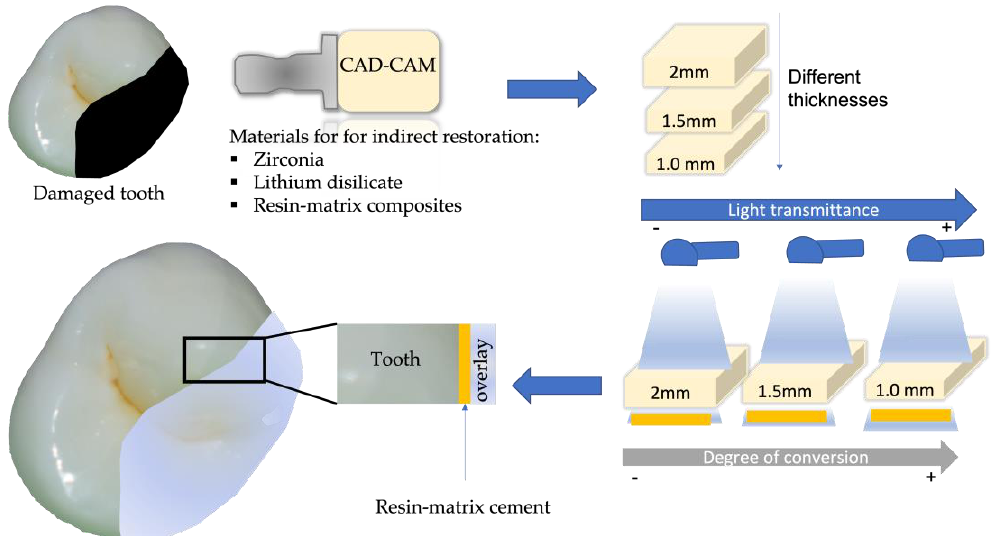
Figure 3. Schematics on the influence of different indirect restorative materials and material thick- nesses on light transmittance and the degree of conversion of resin-matrix cement.